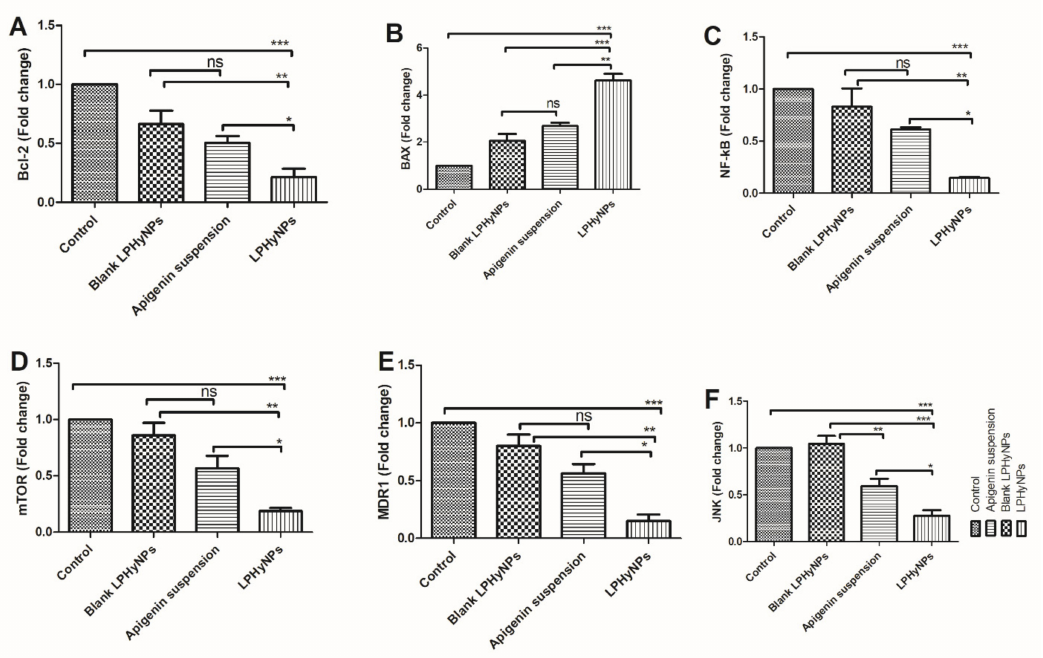
Figure 10. Showing the the outcome of RT-PCR on various formulations such as blank LPHyNPs, AGN suspension, and LPHyNPs. ( A ) represent mRNA expression of Bcl-2, ( B ) represent mRNA expression of BAX, ( C ) represent mRNA expression of NF-kB, ( D ) represent mRNA expression of mTOR, ( E ) represent mTNs expression of MDR1 and ( F ) represent mRNA expression of JNK. Values are presented as mean ± SD where * ( p < 0.05: p < 0.01 and p < 0.01) was represented by *, **, and ***. ‘ns’ demonstrated non-significance differences between